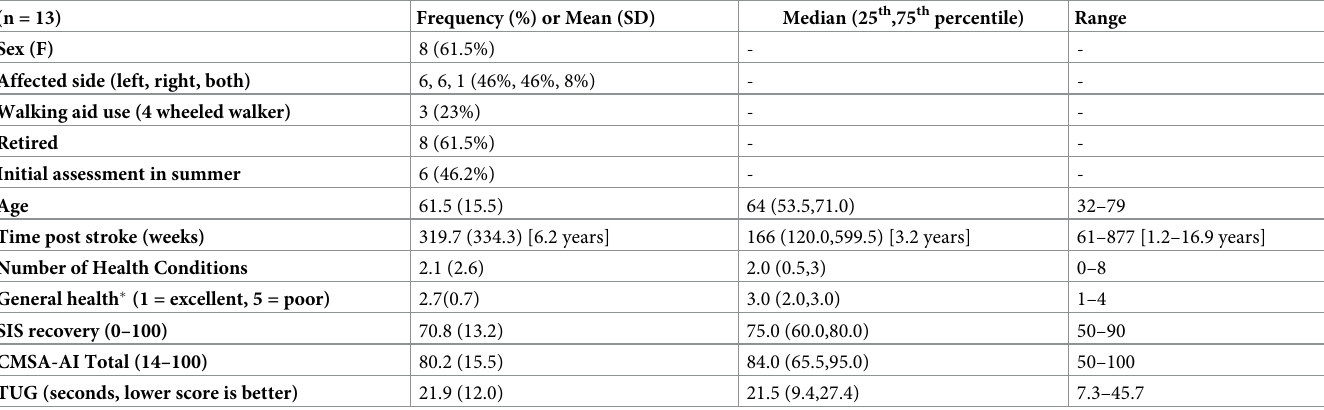
Table 1. Participant characteristics at initial